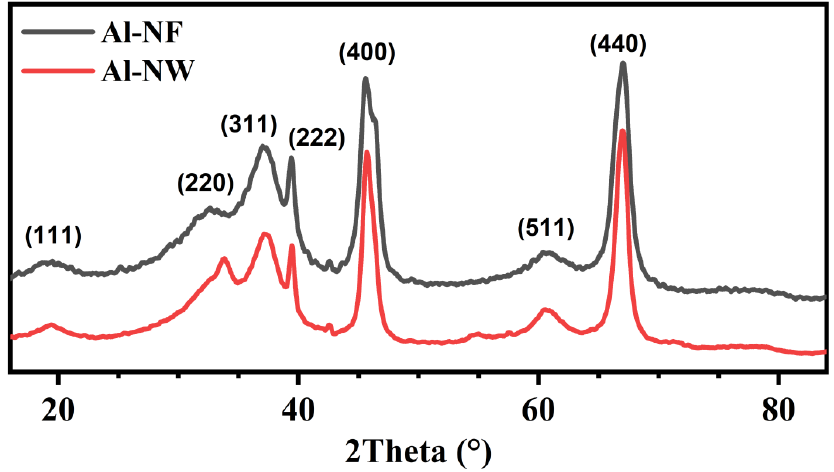
Figure 2. XRD patterns of synthesized nanoflake (Al-NF) and nanowire (Al-NW) γ -Al 2 O 3 . HRTEM observations were subsequently carried out to confirm the microstructural characteristics of the γ -Al 2 O 3 samples which were earlier inferred from the XRD patterns. The sample prepared in part 2.2 using Al 3+ /AlO 2- exhibited highly distributed γ -AlOOH- based nanoflakes. After calcination at 550 ◦ C, γ -AlOOH transformed into γ -Al 2 O 3 [32–34], and the TEM image of γ -Al 2 O 3 nanoflake (Al-NF) has been depicted in Figure 3a. The lengths and thickness of the as-prepared Al-NF were about 200 nm and 40 nm, respec- tively. Besides, the developed nanoflakes manifested straight edges with angles measuring 76 ◦ and 104 ◦ , which corresponded to the angle between the (101) and ( − 101) faces of γ -AlOOH [28,29,35], indicating γ -AlOOH nanoflakes grew with basal planes and lateral faces of (010) and (101). The Al-NF therefore directly inherited the morphology of γ -AlOOH nanoflakes and the exposed γ -AlOOH faces (010) and (101) were converted to basal planes and lateral faces of (110) and (111) of γ -Al 2 O 3 by topological rules [36,37]. The highly magnified TEM image of the γ -Al 2 O 3 nanoflake has been shown in Figure 3c. The lattice fringes of Al-NF with a d -spacing of 0.225 nm, corresponding to the (110) plane of γ -Al 2 O 3 , can be observed clearly [38]. The protocol described in part 2.3 produced γ -Al 2 O 3 nanowires (Al-NW) as shown in Figure 3b. The lengths and diameters of the as-prepared Al-NW were observed to be 100 nm and 10 nm, respectively. Figure 3d is a representation of HRTEM images where lattice fringes attributed to (100) planes of the γ -Al 2 O 3 phase, can be observed.